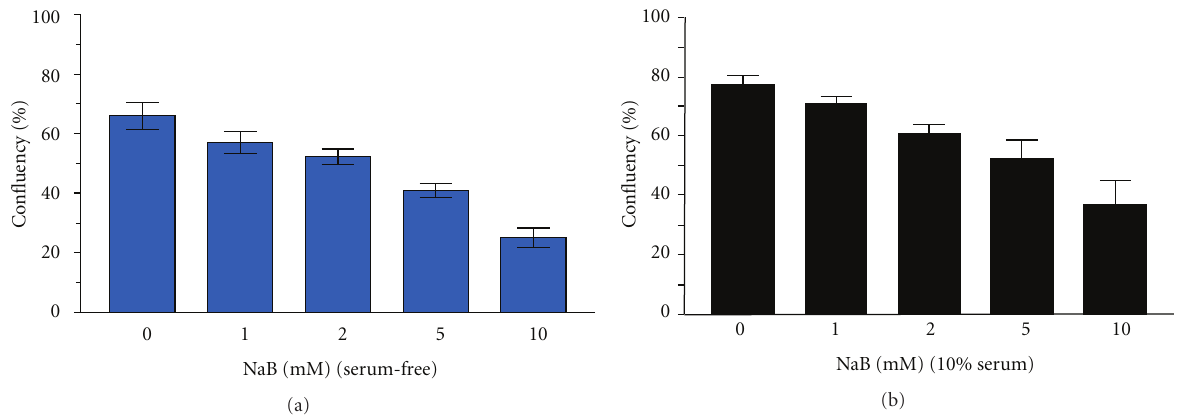
Figure 3: NaB suppressed cell growth in serum-free or supplemented culture conditions. Proliferative restriction was maximal at 10 mM resulting in final population densities of just 47% (a) and 52% (b) compared to respective controls. Data plotted is the mean ± standard deviation for triplicate assessments of final cell densities (i.e., % confluency) for each NaB concentration under the two growth